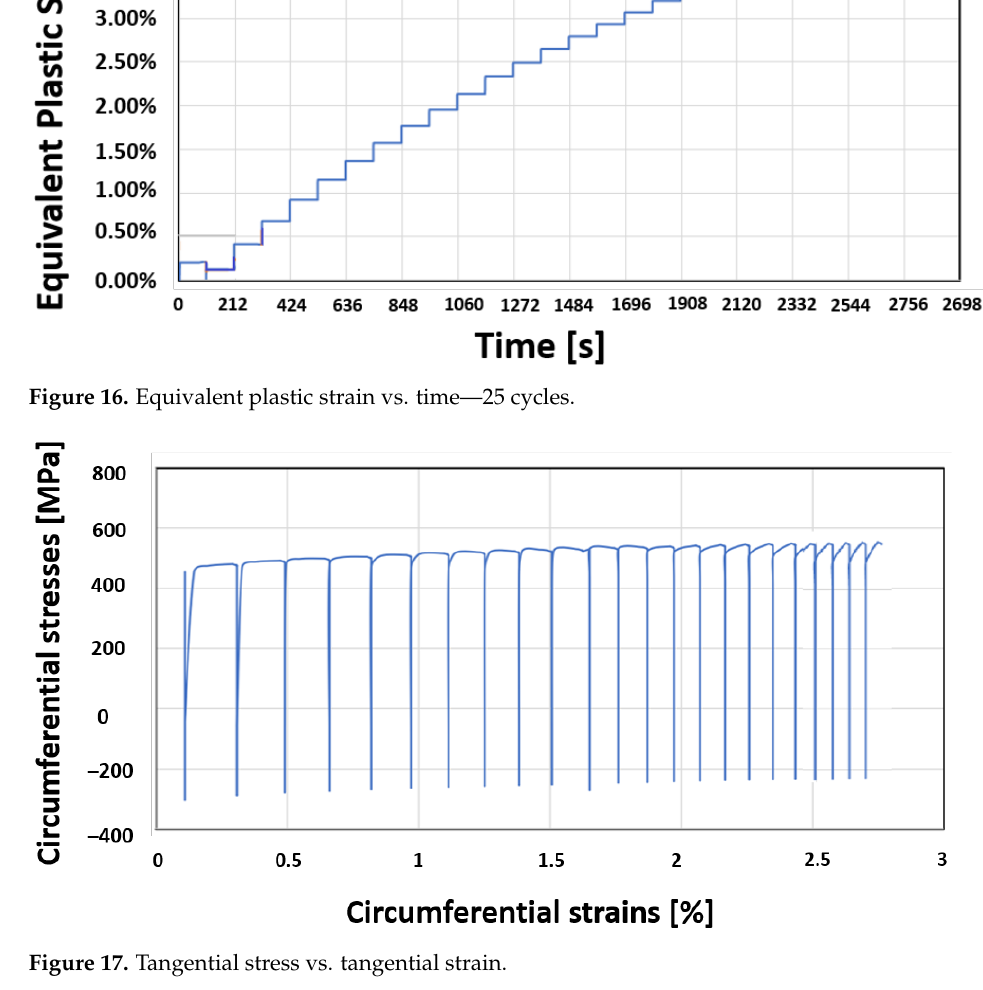
Figure 17. Tangential stress vs. tangential strain.